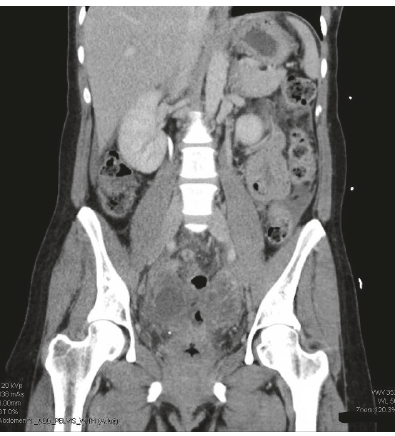
Figure 1: Coronal CT image demonstrating abscess at vaginal cuff.